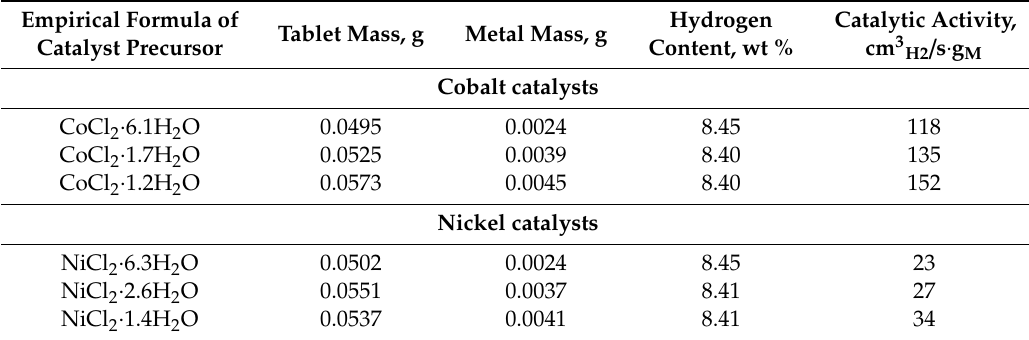
Table 2. Kinetics parameters of hydrogen generation during sodium borohydride hydrolysis over cobalt and nickel catalysts.